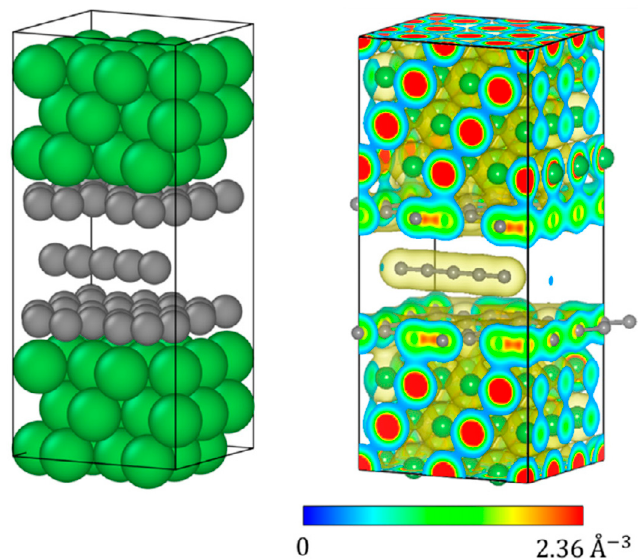
Figure 5. A visual of nanocomposite composed of carbyne sandwiched by graphene, which is itself embedded in a Ni matrix. Reproduced with permission from